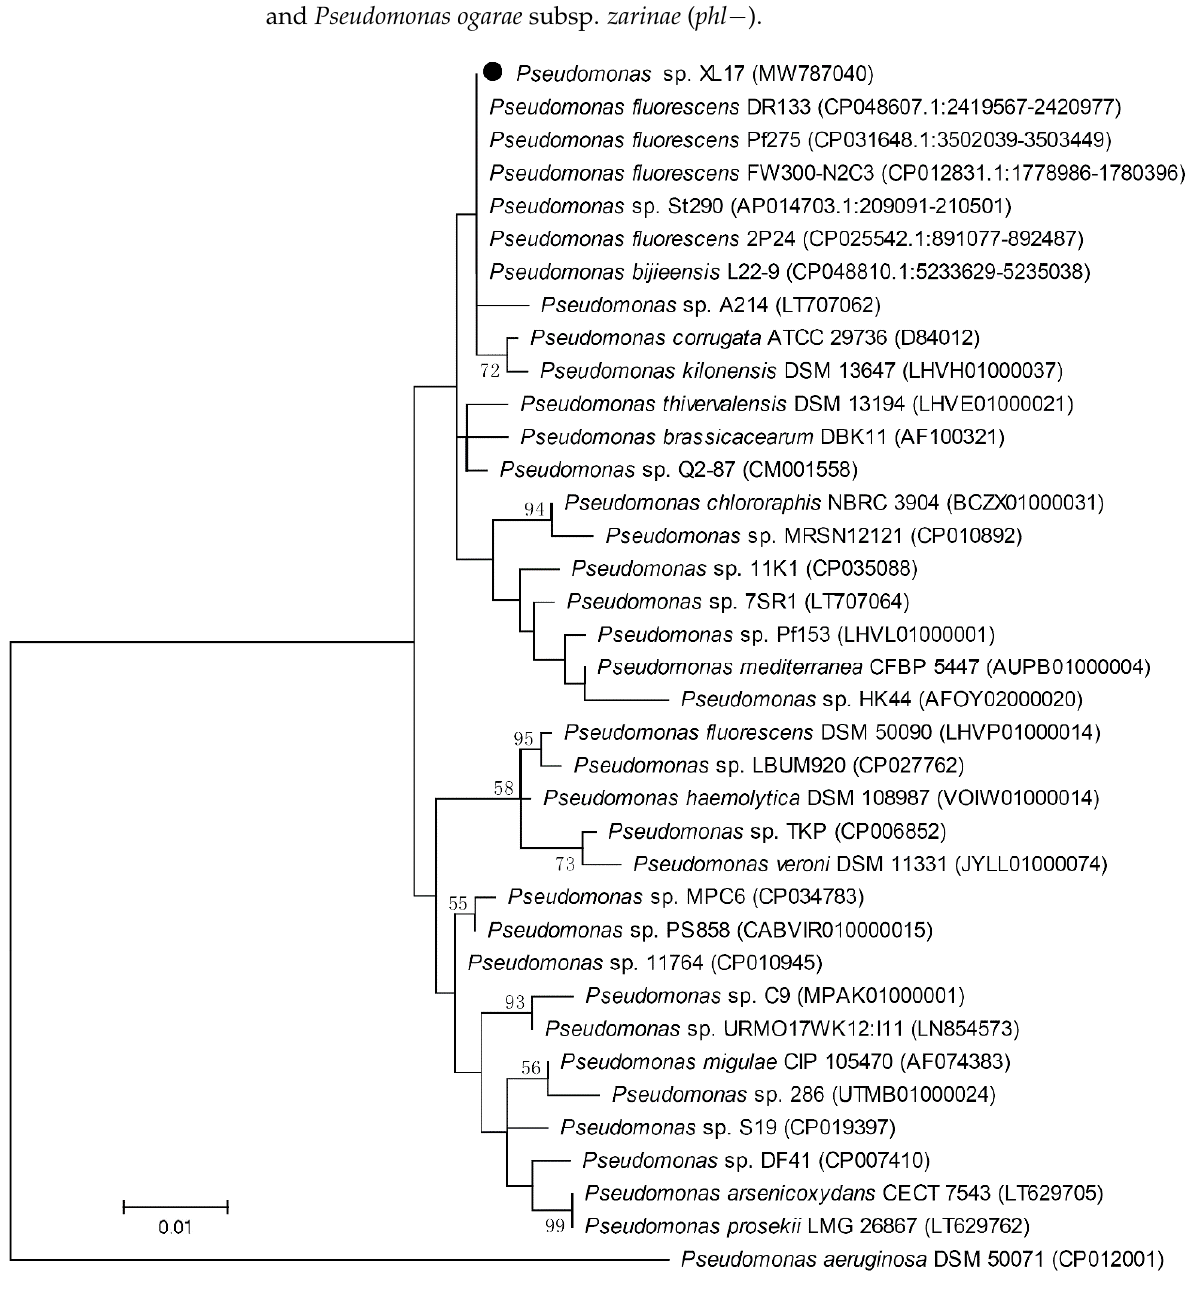
Figure 5. Maximum likelihood phylogenetic tree based on 16S rRNA gene sequences (1405 positions) of strain XL17 ( • ) and related Pseudomonas strains. Pseudomonas aeruginosa DSM 50071 T was used as outgroup. The percentages of replicate trees (>50%) in which the associated taxa clustered together in the bootstrap test (1000 replicates) are shown at the nodes. The GenBank accession numbers of the 16S rRNA gene sequences are indicated in brackets. The scale bar indicates 0.01 substitutions per site.